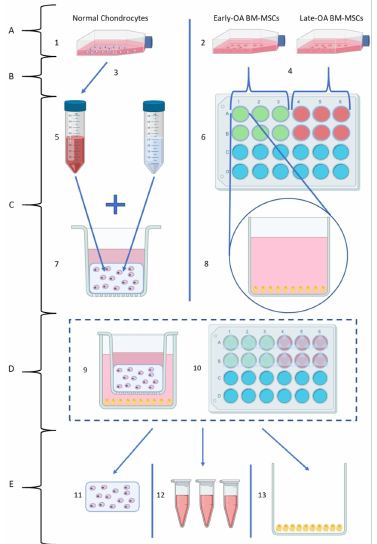
Figure 1. Overview of the co-culture model (created using Biorender.com). ( A ) Recovery of cells from long-term storage: (1) Chondrocytes were recovered from liquid nitrogen storage and cultured in monolayer. (2) Donor-matched BM-MSC populations recovered from liquid nitrogen storage and cultured in monolayer. ( B ) Cell Collection: (3) Once 80% confluent, chondrocytes were collected by trypsinisation, and the required number for the model was separated from the suspension. (4) Once 80% confluent, BM-MSCs were collected by trypsinisation and counted, and the required number for the model was separated from the suspension. ( C ) Individual cell preparation for co-culture model: (5) Chondrocyte suspension was combined with 4% agarose solution to form a 1:1 mixture. (6) Donor-matched early OA and late-OA BM-MSCs seeded in 24-well plates (top view). (7) Agarose– chondrocyte mixture pipetted into 24-well plate transwell inserts. (8) BM-MSCs in 24-well plate (side-view) with osteogenic differentiation media added. ( D ) Co-culture setup: (9) Co-culture model (individual well, side view). (10) Co-culture model (full plate, top view). ( E ) Harvest of the co-culture model for analysis at endpoints (day 0, day 7, day 14 and day 21): (11) Chondrocyte–agarose scaffolds were removed for gene expression, histological and biochemical analyses. (12) Conditioned medium was removed for analysis of secreted protein abundance by ELISA. (13) BM-MSCs removed for gene expression and biochemical analyses (data not